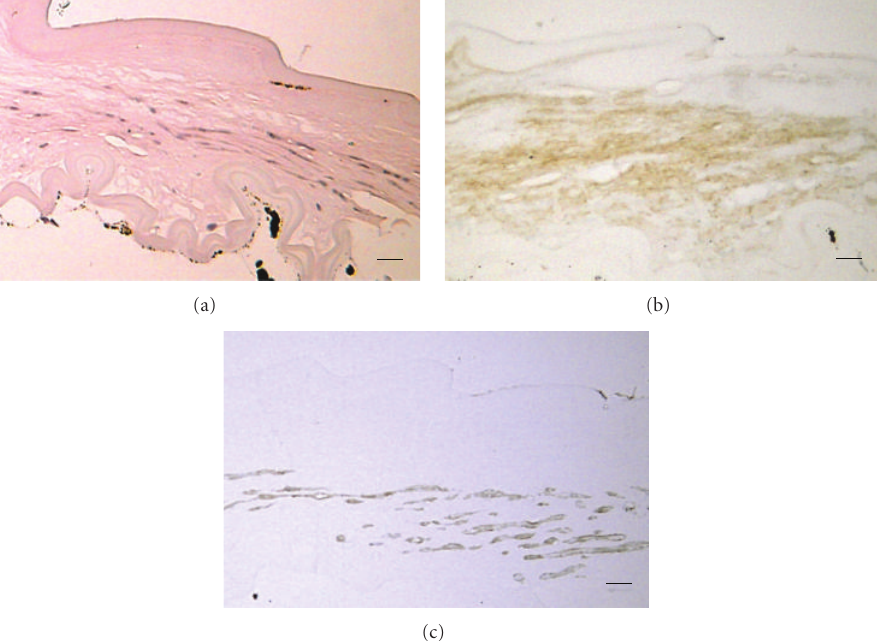
Figure 6: The remnant lens with HE staining (a). The contents of the crystalline lens were absorbed and fibrous tissue was present between anterior and posterior capsule. Immunohistochemistry for Collagen types I (b) and α SMA (c). Bar: 10 μ